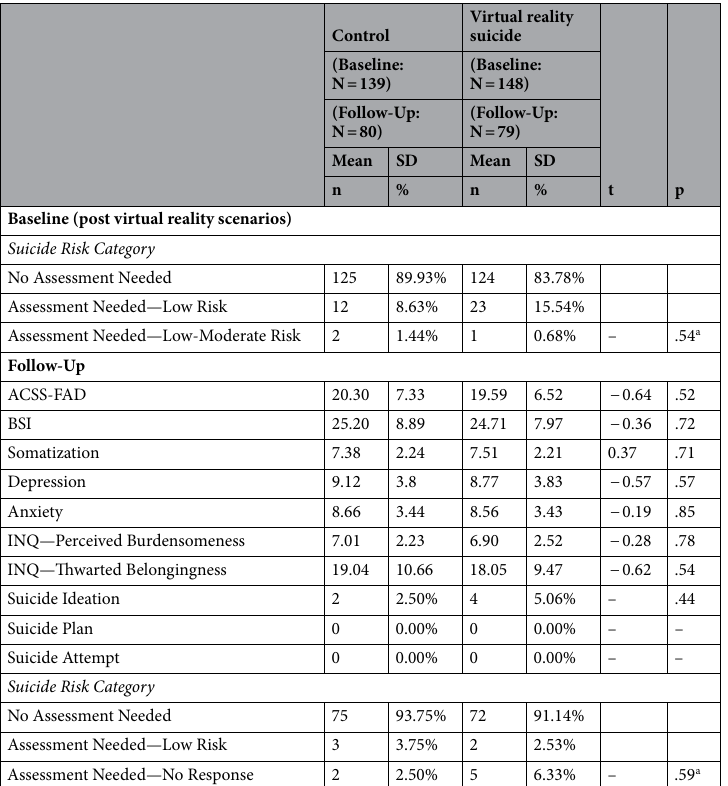
Table 2. Study 2 results. a Fisher’s exact test; ACSS-FAD = Acquired Capability for Suicide Scale—Fearlessness about Death; BSI = Brief Symptom Inventory; INQ = Interpersonal Needs Questionnaire; PB = Perceived Burdensomeness; TB = Thwarted